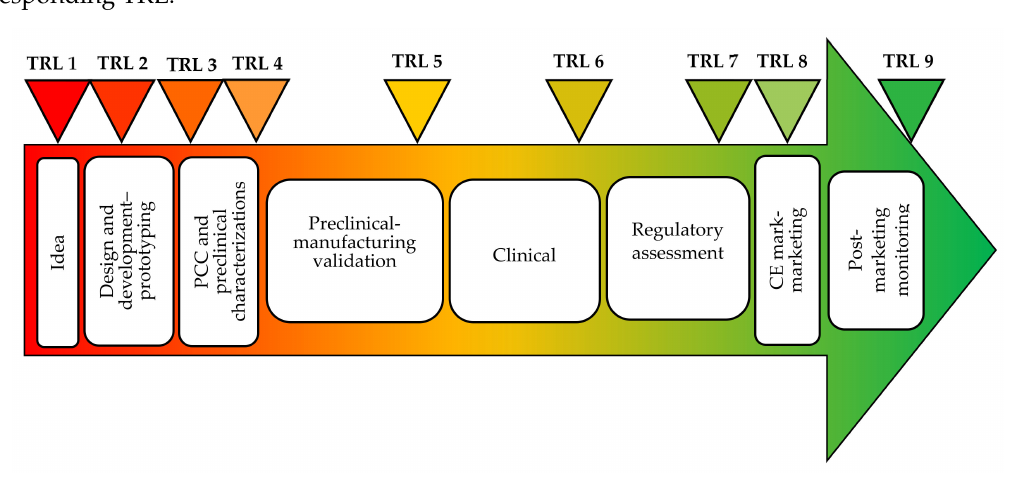
Figure 4. From the idea to the market of a MD. Modified from [77]. CC BY